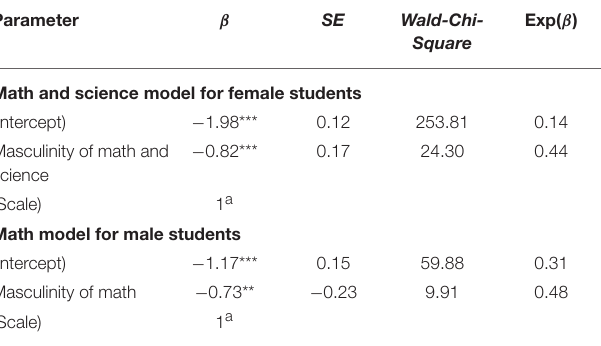
TABLE 3 | Impact of the masculine image of math and science on secondary students’ career